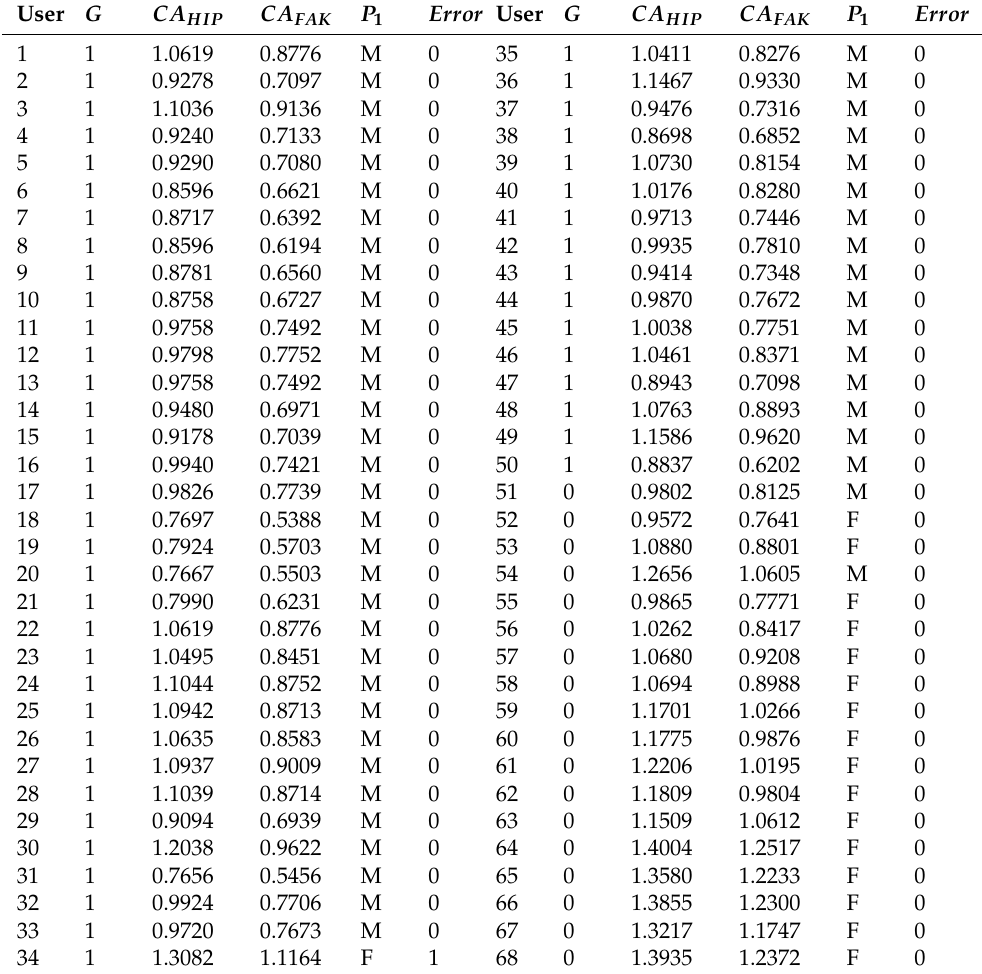
joints cluster: left knee, right knee, right ankle, left ankle, left foot, and right foot. Hip cluster: left hip, hip centre, and right hip. The issue of multicollinearity and the variance of the error term was minimised by clustering the means of the lower-body joints. The issue of multicollinearity may arise in overdefined models (many independent variables) and result in high variation. The cluster means resulted in the best fitted model for gender classification during walking by reducing the number of predictors (joints) from nine to just two joints (hip and lower-body joints). Table 5. The results of the best-fit binary logistic regression model for gender